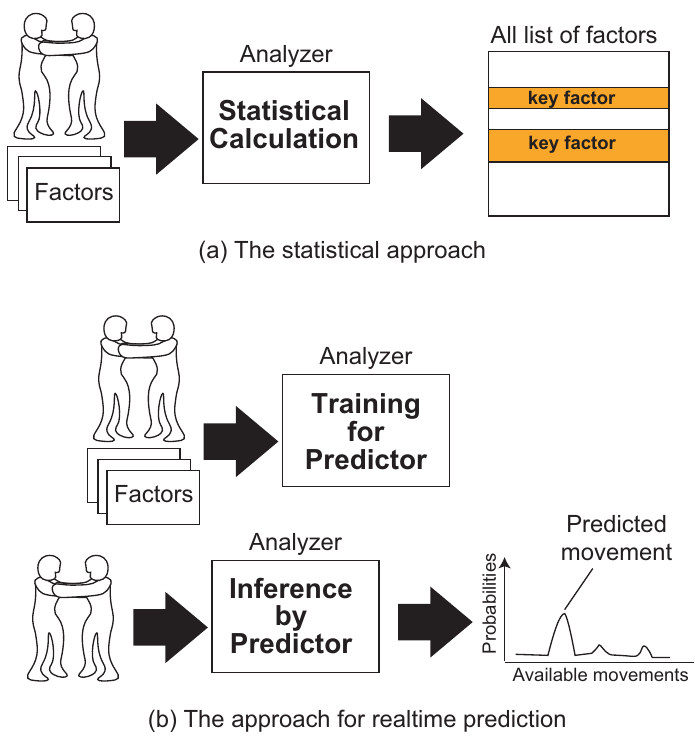
Figure 1. Two approaches for predicting the successful movement. ( a ) shows the statistical approach that the key factors are after analyzing the all datasets. ( b ) shows the approach that infers the successful movement by using the dataset taken in